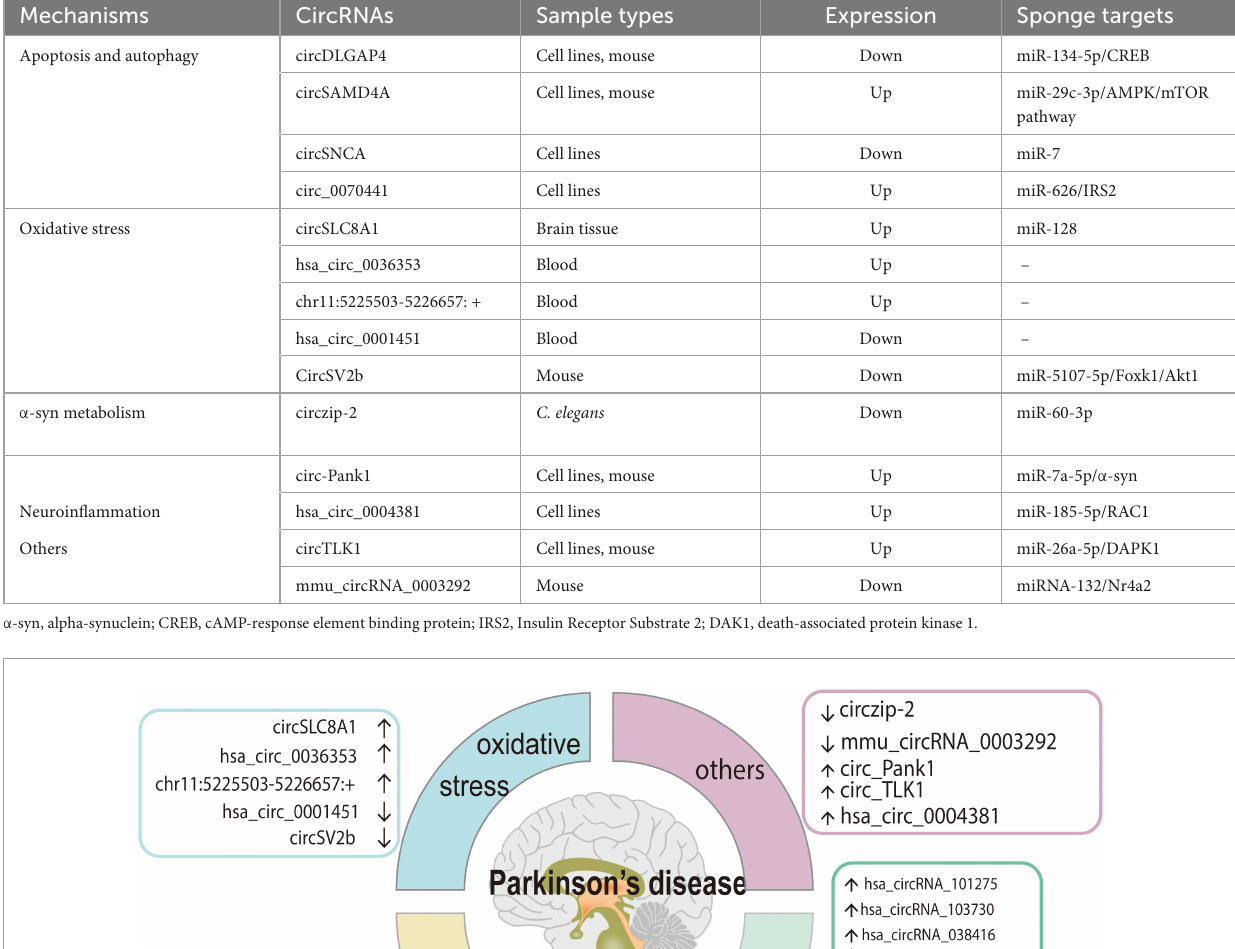
TABLE 1 Dysregulated circRNAs in Parkinson’s